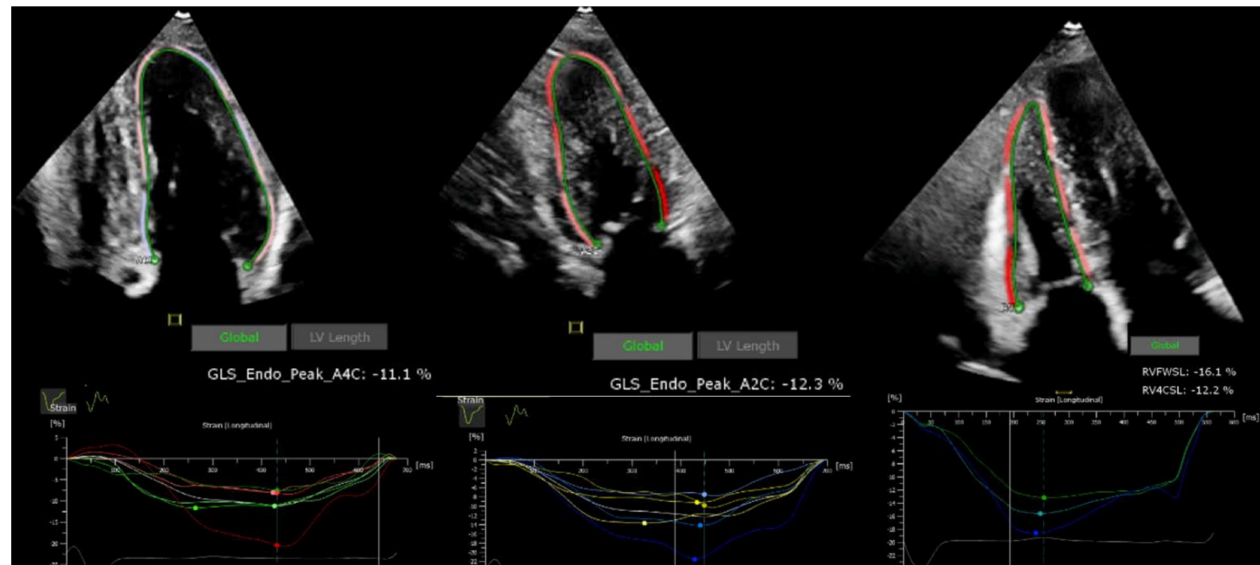
Figure 5. Strain TTE in a patient with Fabry Cardiomyopathy. Left: GLS assessment of the LV from the apical 4-chamber view demonstrating reduced GLS ( − 11.1%); Middle: GLS assessment of the LV from the apical 2-chamber view demonstrating reduced GLS ( − 12.3%); Right: GLS assessment of the RV from the Apical 4-chamber view demonstrating reduced GLS (free wall strain − 16.1% and longitudinal strain −